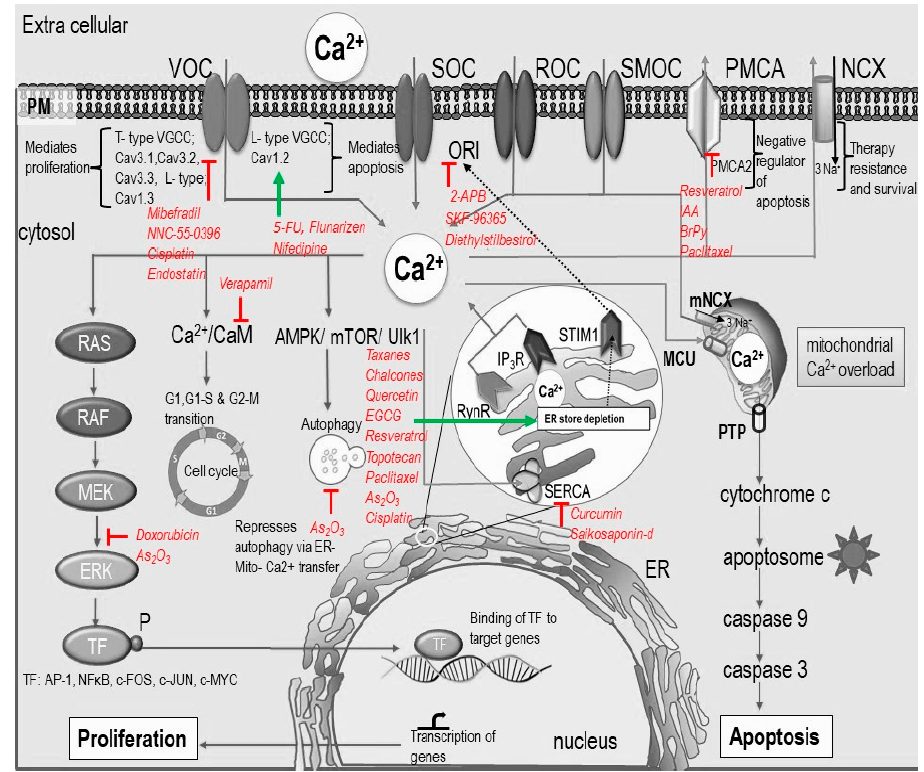
Figure 2. Intra-cellular calcium response to anti-cancer agents. This schematic representation shows the effect of anti-cancer agents on calcium signaling and its downstream effect on apoptosis and proliferation. Anti-cancer drugs can target different calcium channels and pumps on the plasma membrane, ER, and mitochondria. ER-mitochondrial Ca 2+ transfer plays an important role in apoptosis and many anti-cancer drugs target ER to induce apoptosis. Anti-cancer drugs can also be anti-proliferative (e.g., Doxorubicin) by targeting Ca 2+ -signaling that regulate various proliferation pathways and cell cycle progression. Green arrows represent activation and red lines represent a block.